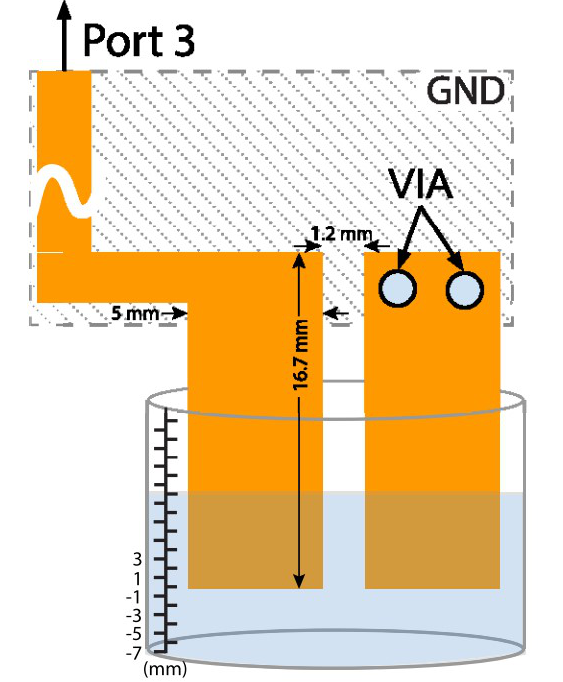
Figure 22. The layout of chip–based multi–port flood sensor [39].